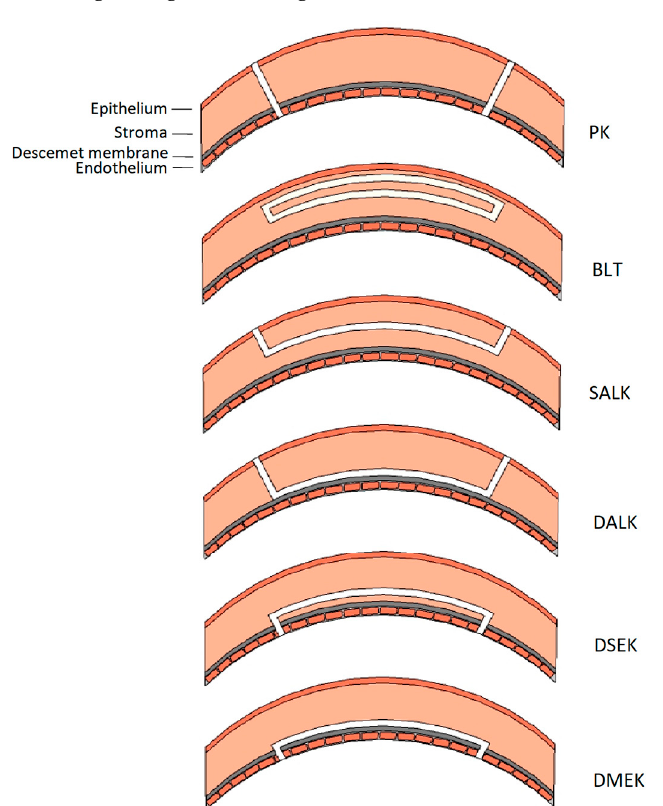
Figure 1. Schematic representation of the different types of keratoplasty. The white section repre- sents the transplanted tissue. PK = penetrating keratoplasty. BLT = Bowman layer transplantation. SALK = superficial anterior lamellar keratoplasty. DALK = deep anterior lamellar keratoplasty. DSEK = Descemet stripping endothelial keratoplasty. DMEK = Descemet membrane endothelial